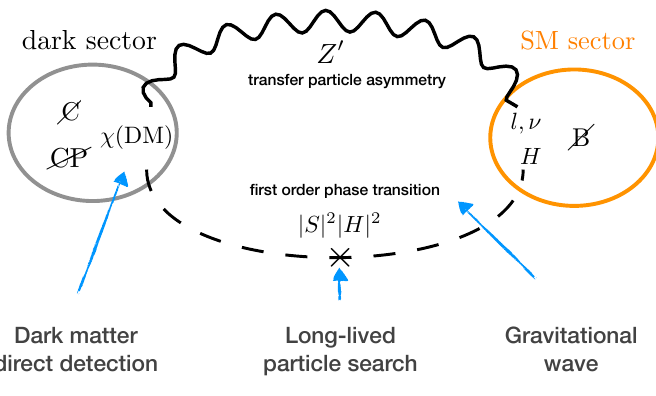
Figure 1. Low energy sector of the model and probes for EWBG and a dark matter candidate.